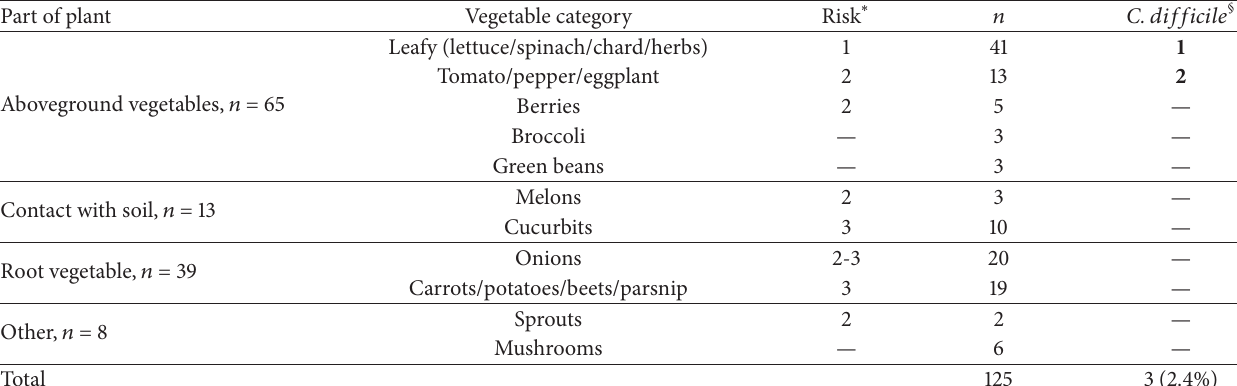
Table 1: Retail fresh vegetables tested for Clostridium difficile in Ohio,